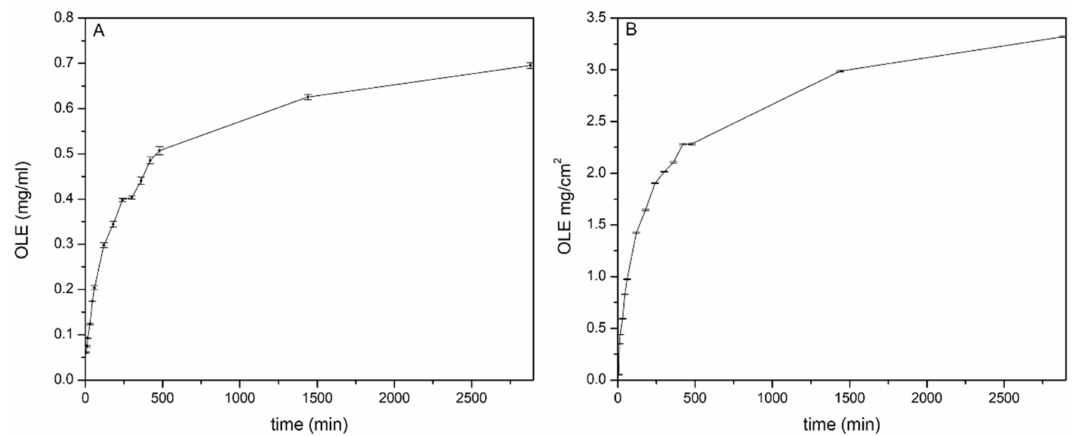
Figure 6. ( A ) OLE In vitro release profile of from the hydrogel film B2 represented as mg / mL vs. time and ( B ) mg / cm 2 vs.